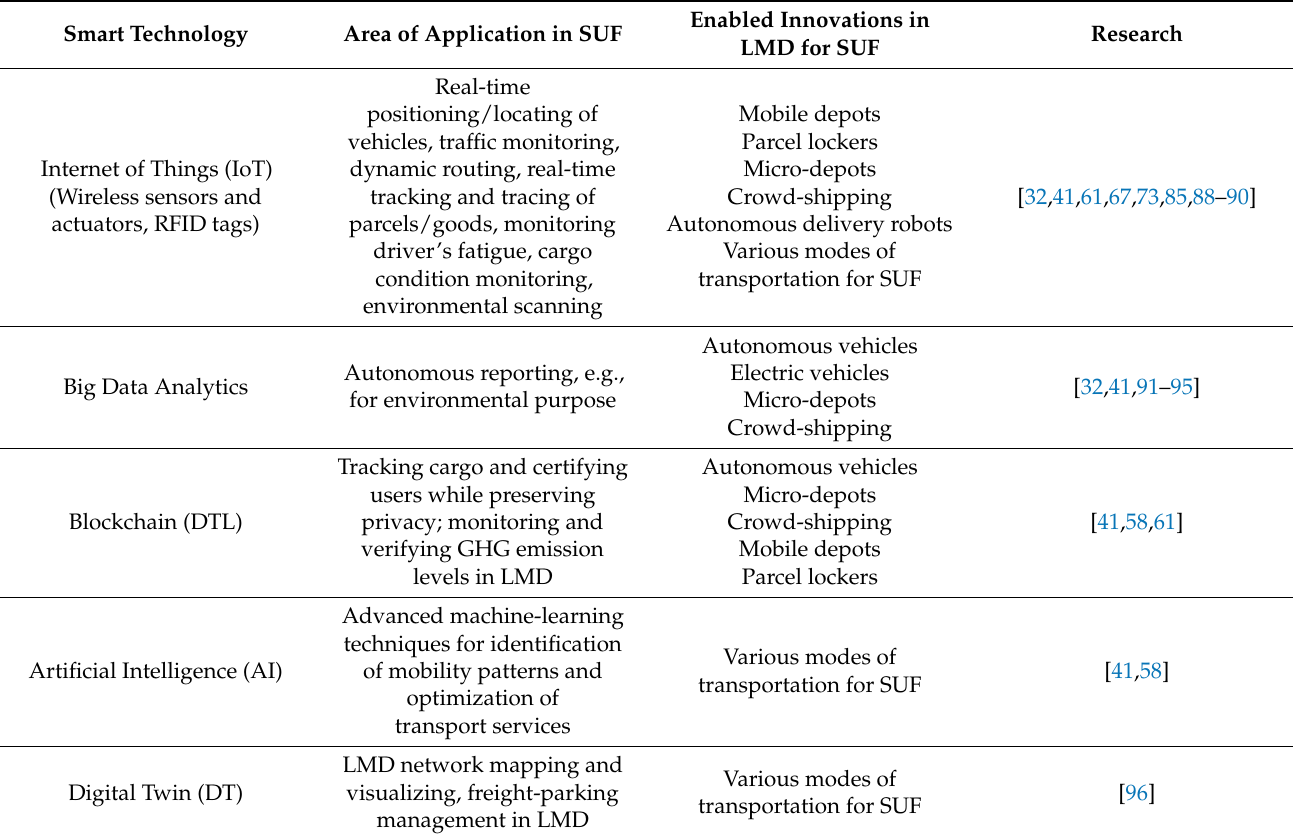
Table 5. Smart city technologies for sustainable urban freight and energy-efficiency. Smart